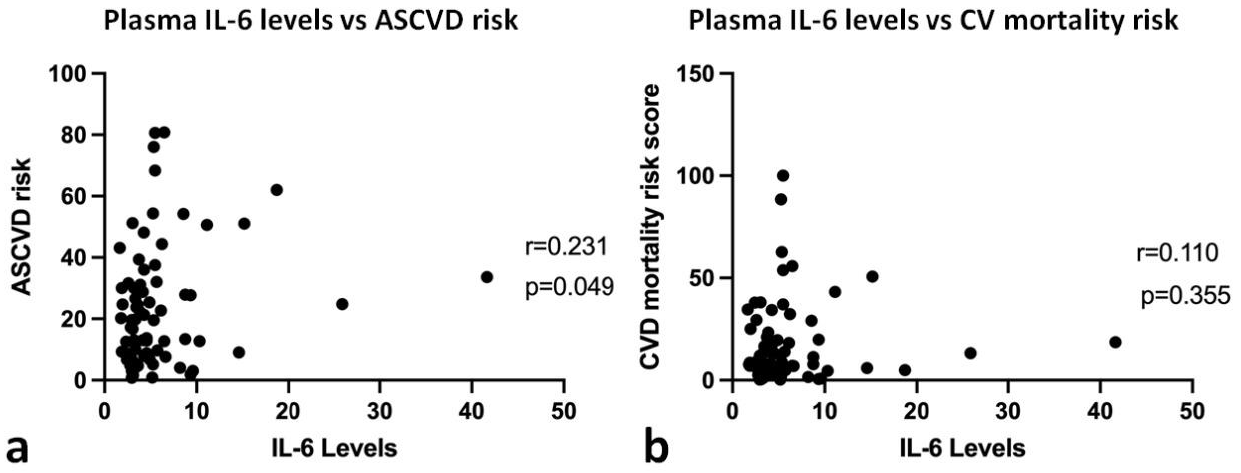
Figure 3. Path analysis between plasma IL-6 level, ASCVD risk score, and cardiovascular mortality risk score. 3.3. Analysis of IL-6 G174C SNP in Javanese CKD Patients It has been known that plasma IL-6 level is significantly correlated with the G174C polymorphism [19,25,36]. To detect the frequency of IL-6 G174C SNP in this study partic- ipants, we performed PCR-RFLP followed by direct sequencing for confirmation. Chro- matogram comparison and multiple alignments between SNP and major homozygote are presented in Figures 4 and 5. As shown in Table 2, in this study, we only found one Java- nese CKD patient with GC genotype (1.37%) and one patient with CC genotype (1.37%). According to the allele calculation, only three C alleles were found in this study (2.05%). The frequency of the G allele (100%) and C allele (0%) in this study population seemed to be comparable with the reported frequency in the Asian population (dbSNP, NCBI) [37]. As the number of polymorphic alleles in this cohort was very low (only one subject each in both GC and CC genotypes), we did not perform correlation analysis due to the limited power of the statistical test.